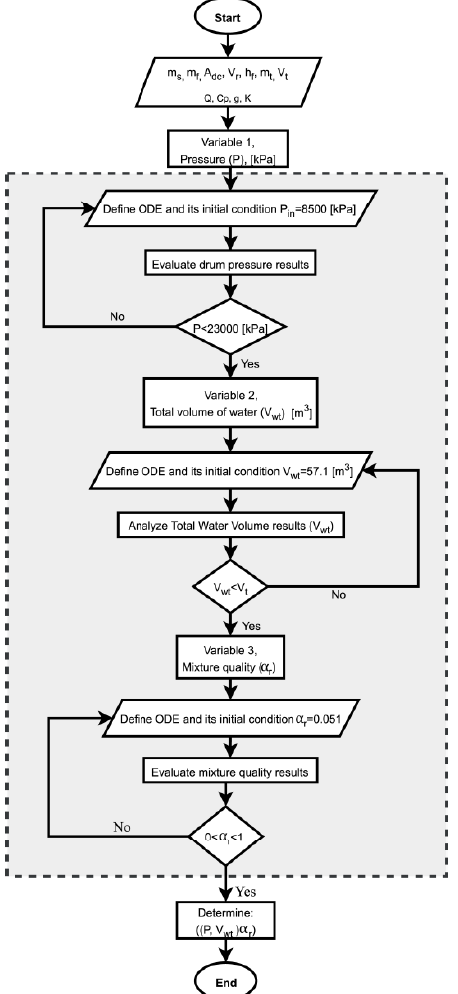
Figure 5. Flow chart of the code develop in MATLAB ® for the Ode solution.